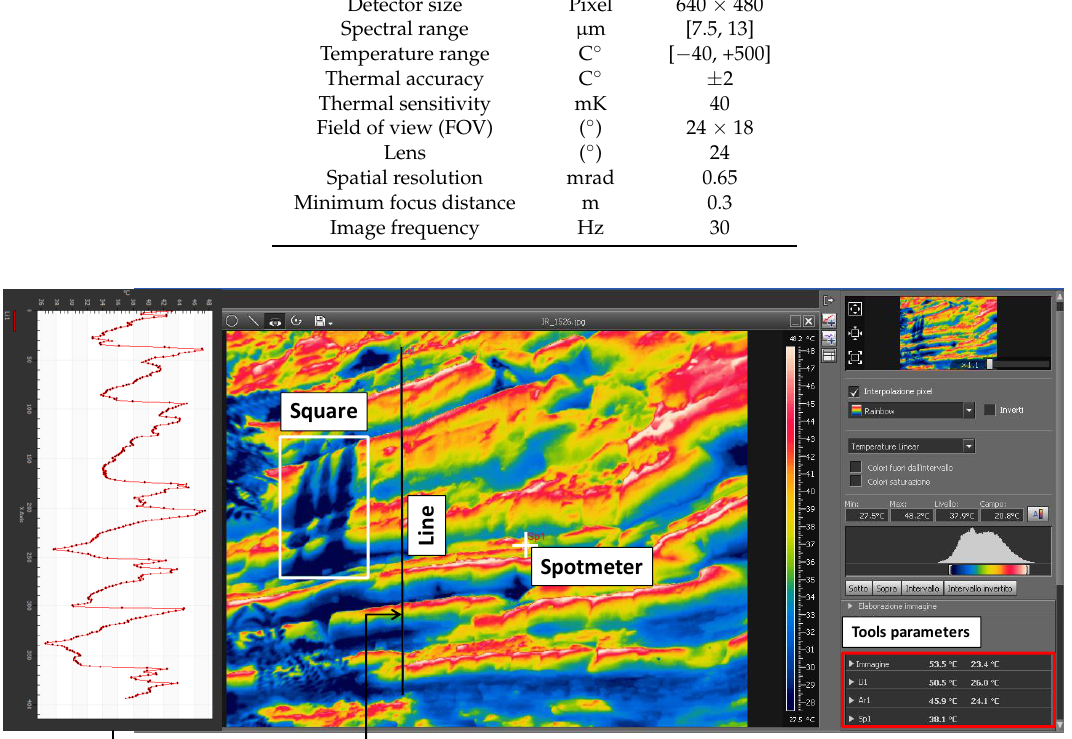
Table 1. FLIR SC620 thermal camera main technical specifications.